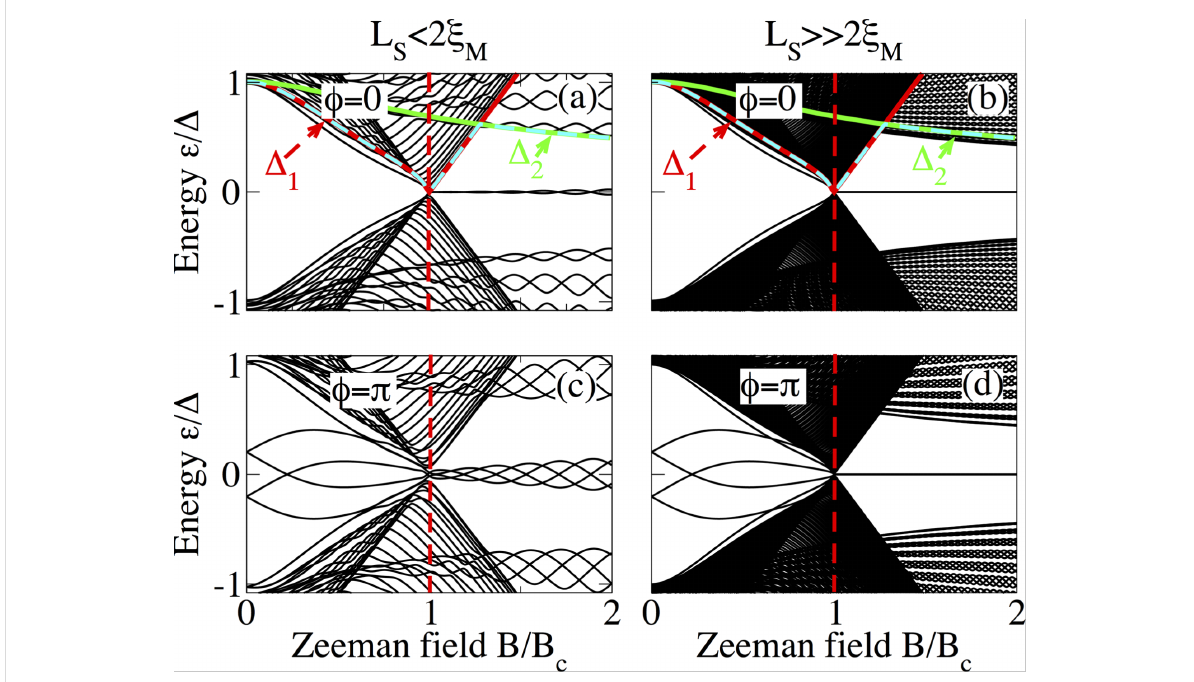
Figure 8: Low-energy Andreev spectrum as a function of the Zeeman field in a short SNS junction at = 0 (a,b) and = π (c,d) with L S = 2000 nm (a,c) and L S = 10000 nm (b,d). The low-energy spectrum traces the gap closing and reopening by the solid red curve that corresponds to Δ 1 , while for B > B c we observe the emergence of two MBSs at = 0 (a) and four MBSs at = π (c), which oscillate around zero energy with B due to L S ≤ 2 ξ M within a minigap defined by Δ 2 (solid green curve). For